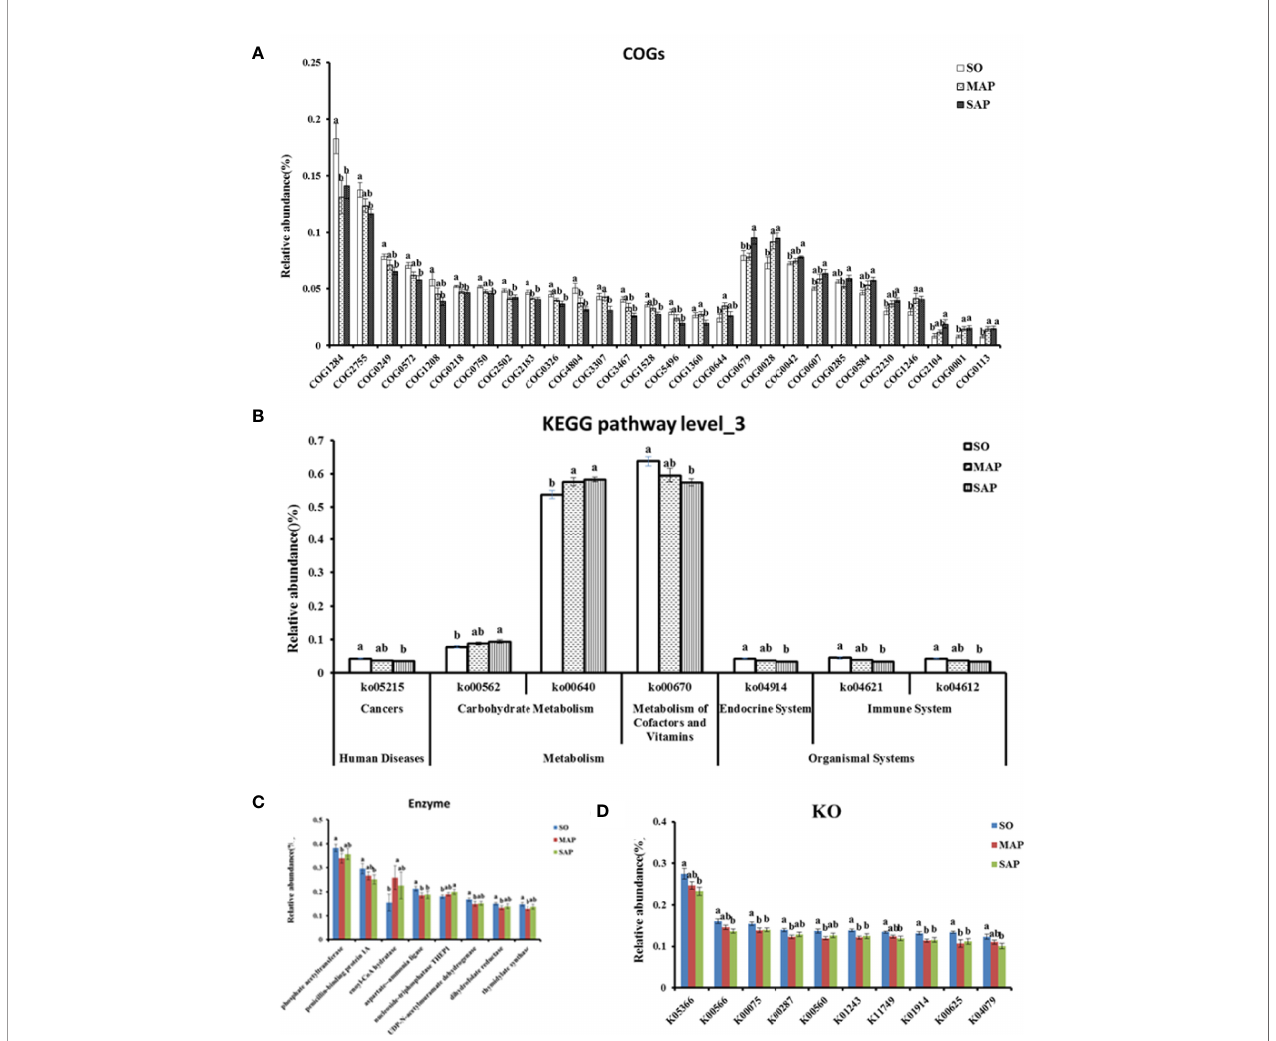
FIGURE 7 | Signi fi cant difference in function predicted for COGs (A) , KEGG pathway level_3 (B) , Enzyme (C) , and KO (D) . SO, Sham operation; MAP, Mild acute pancreatitis; SAP, Severe acute pancreatitis; COG, Cluster of orthologous genes; KEGG, Kyoto Encyclopedia of Genes and Genomes; KO, KEGG orthology. Data are shown as mean ± standard error. Different letters (a, b) represent signi fi cant differences between three groups at P <